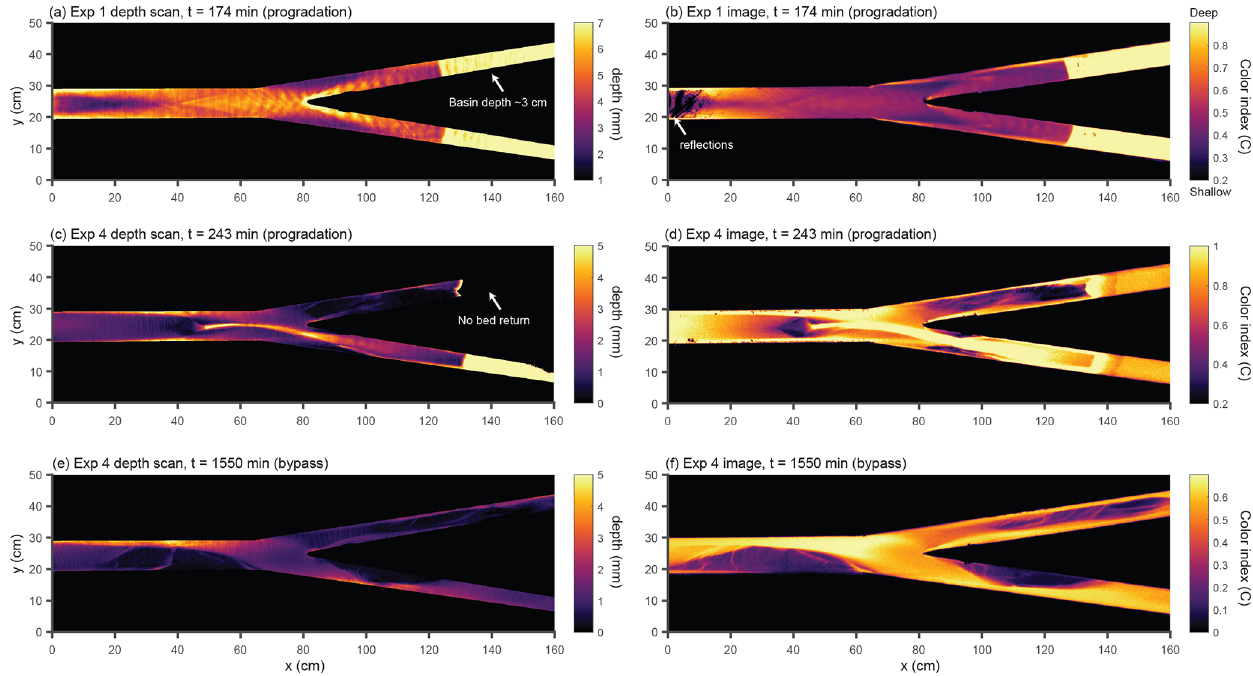
Figure 2. Comparison between water depth obtained from topographic scans (a, c, e) and the color index C obtained from overhead images (b, d, f) . Although C does not map linearly to the water depth, it qualitatively reproduces the flow depth patterns. Examples are taken from the progradation phase of experiment 1 (a, b) , progradation phase of experiment 4 (c, d) , and bypass phase of experiment 4 (e, f) .